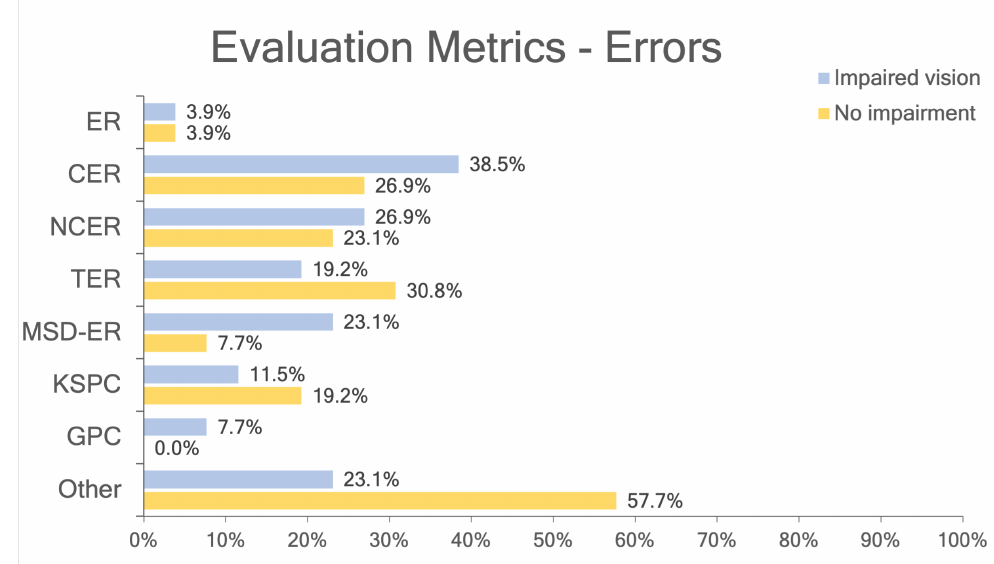
Figure 10. Proportion of studies using each of the error